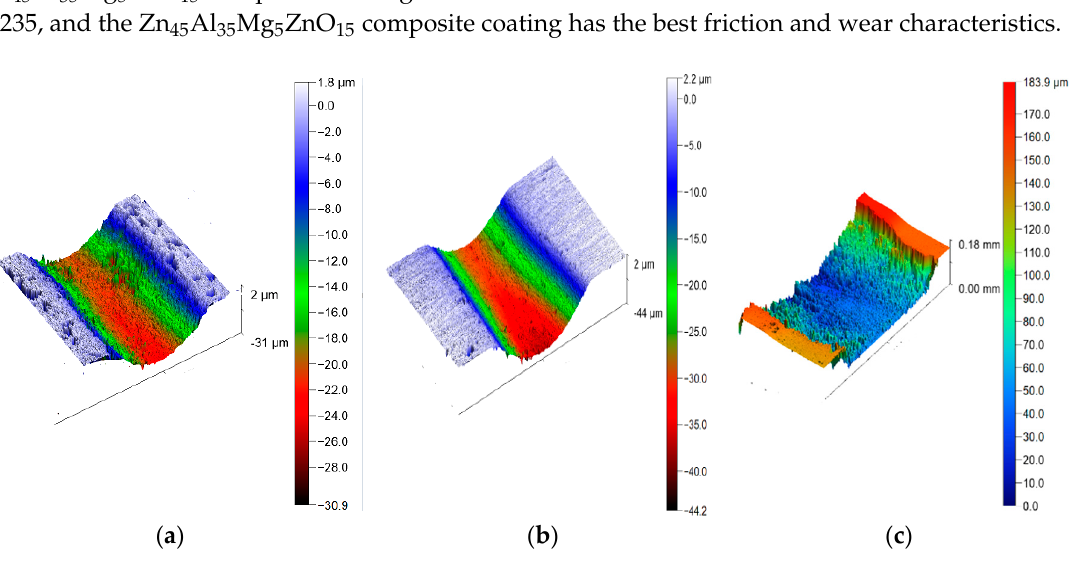
Figure 12. Friction and wear appearance of Zn 65 Al 15 Mg 5 ZnO 15 , Zn 45 Al 35 Mg 5 ZnO 15 , and Q235 matrix steel: ( a ) Zn 45 Al 35 Mg 5 ZnO 15 , ( b ) Zn 65 Al 15 Mg 5 ZnO 15 , and ( c ) Q235. Table 3. Friction and wear data of Zn 65 Al 15 Mg 5 ZnO 15 , Zn 45 Al 35 Mg 5 ZnO 15 , and base steel Q235. Samples